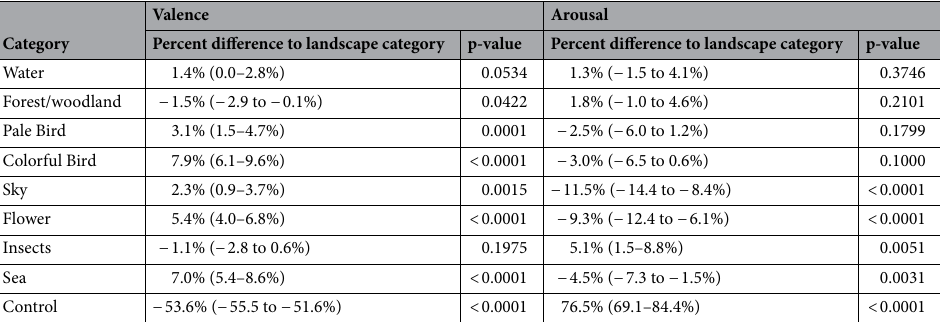
Table 3. Between-category comparisons of valence and arousal ratings. The mean affective ratings of the Landscape category were 6.7 (6.6–6.8) for valence and 4.2 (4.0–4.3) for arousal. *P-values by generalized estimated equations.